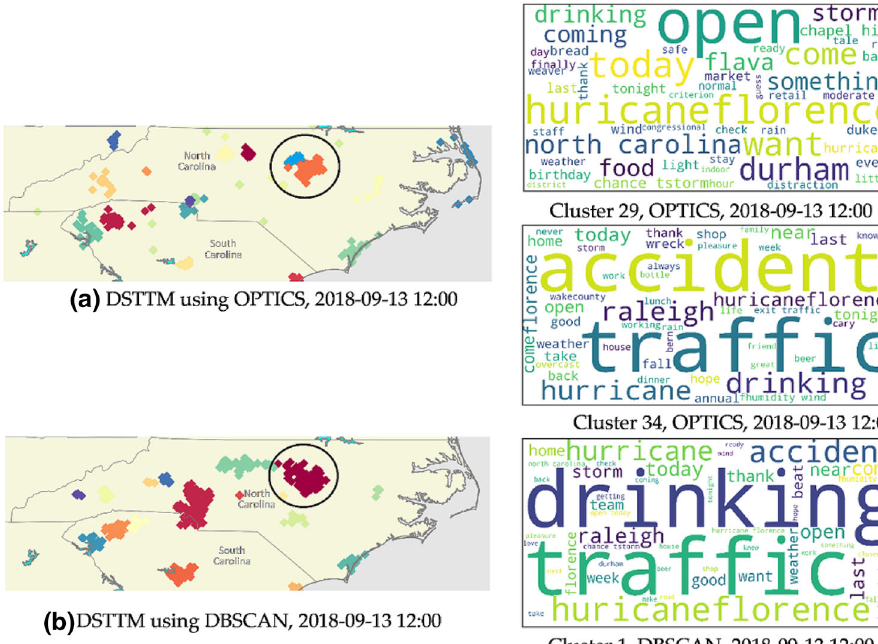
noise (DBSCAN) in dealing with density variation over the study area related to Hurricane Florence in North and South Carolina (on each map, tweet clusters are highlighted with different